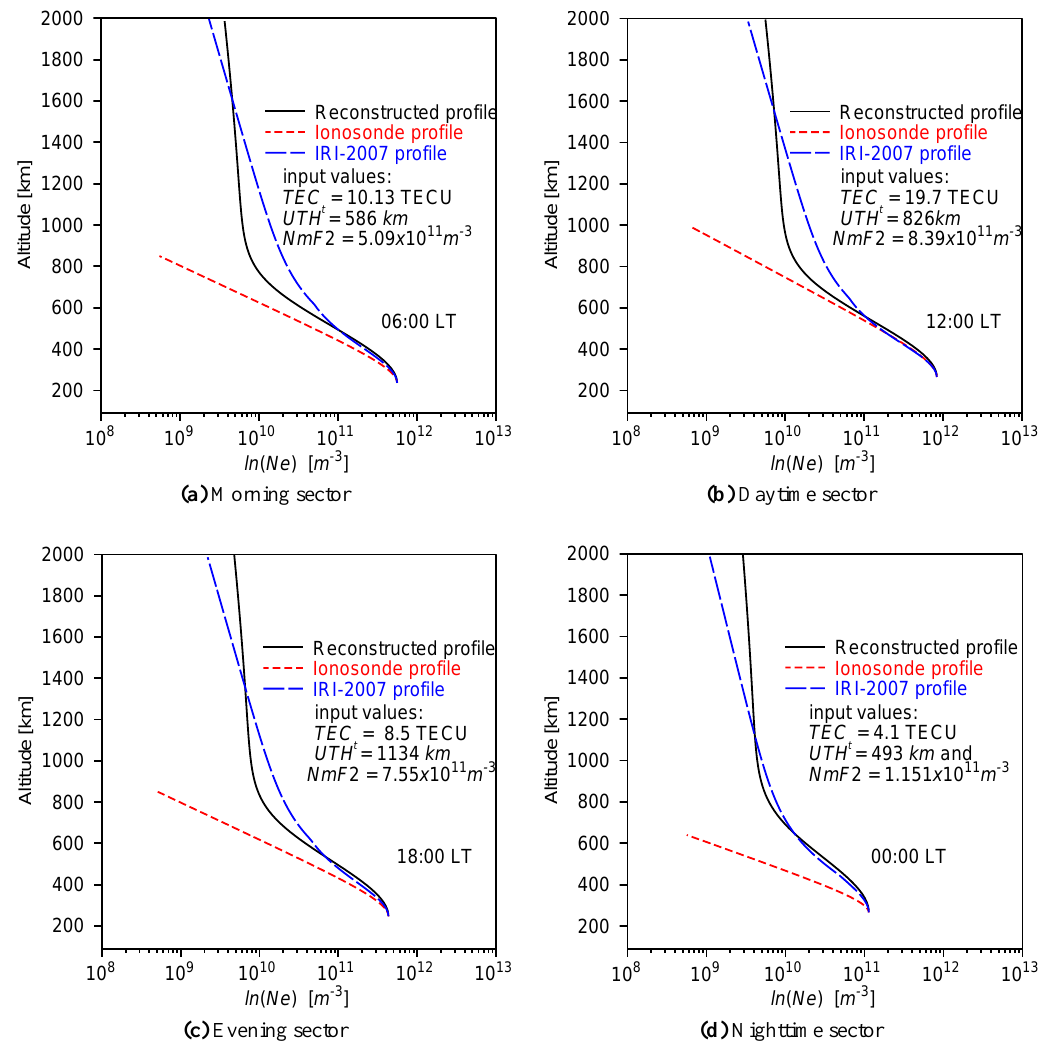
Fig. 4. Reconstructed topside N e profiles for morning (a) , daytime (b) , evening (c) and nighttime (d) sectors compared with the corresponding ionosonde profiles and the IRI-2007 model profiles. Values for the input parameters used are indicated in each